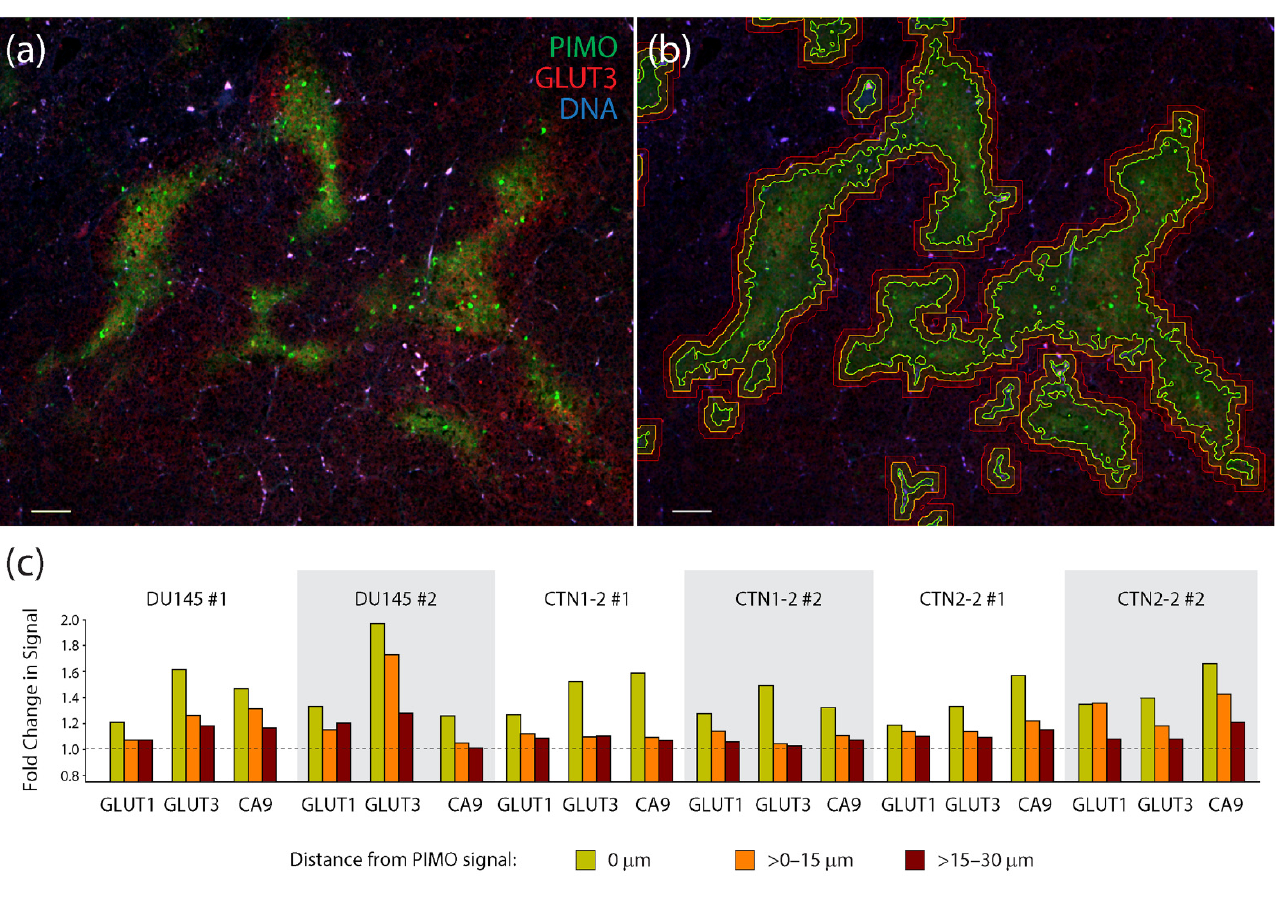
Figure 5. Measurements of the co-localization of hypoxia markers in xenograft tumors show a high degree of association between pimonidazole and GLUT3. ( a ) Single section from a CTN2-2 tumor immunostained for pimonidazole (PIMO) (green) and GLUT3 (red). DNA, blue. Scale, 100 µ m. ( b ) To quantify co-localization of hypoxia markers GLUT1, GLUT3, and CA9 with PIMO, binary tracings were placed around the PIMO signal (green lines) defined a threshold of intensity specific to each tumor. Binaries were then dilated >0–15 µ m (orange lines) and >15–30 µ m (red lines) to capture the adjacent signal of each hypoxia marker. Same image as in ( a ). ( c ) Graphs show fold change in mean fluorescence intensities of hypoxia markers GLUT1, GLUT3 and CA9 within three PIMO-positive or adjacent regions captured within the expanded binary masks: 0 µ m where the PIMO signal resides, >0–15 µ m (orange bars) and >15–30 µ m (red bars). Mean fluorescence intensities within these three regions was divided by ‘background’ signal from regions >30 µ m from the PIMO signal. A dashed line indicates no change in signal relative to the background. Four optical fields in tissue sections from two different DU145, CTN1-2 and CTN2-2 tumors were analyzed (six different tumors examined in